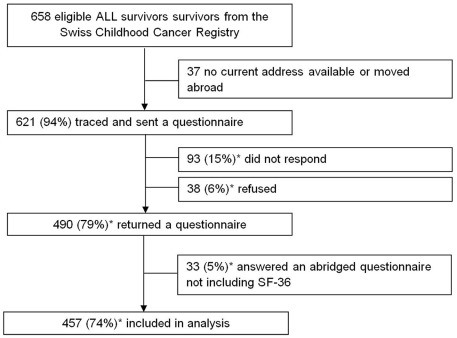
Participant status of acute lymphoblastic leukemia survivors in the Swiss Childhood Cancer Survivor Study.As of May 19, 2011. *of those traced and sent questionnaire. ALL: acute lymphoblastic leukemia; SF-36: Short Form-36.